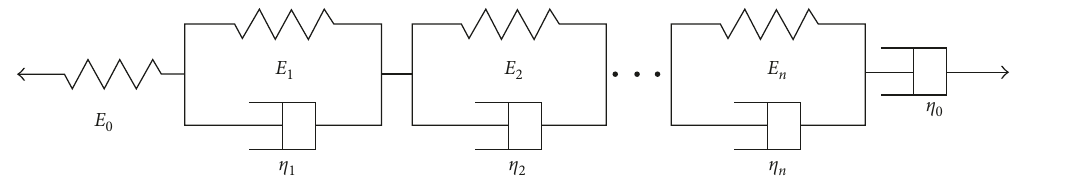
Figure 12: The generalized Kelvin